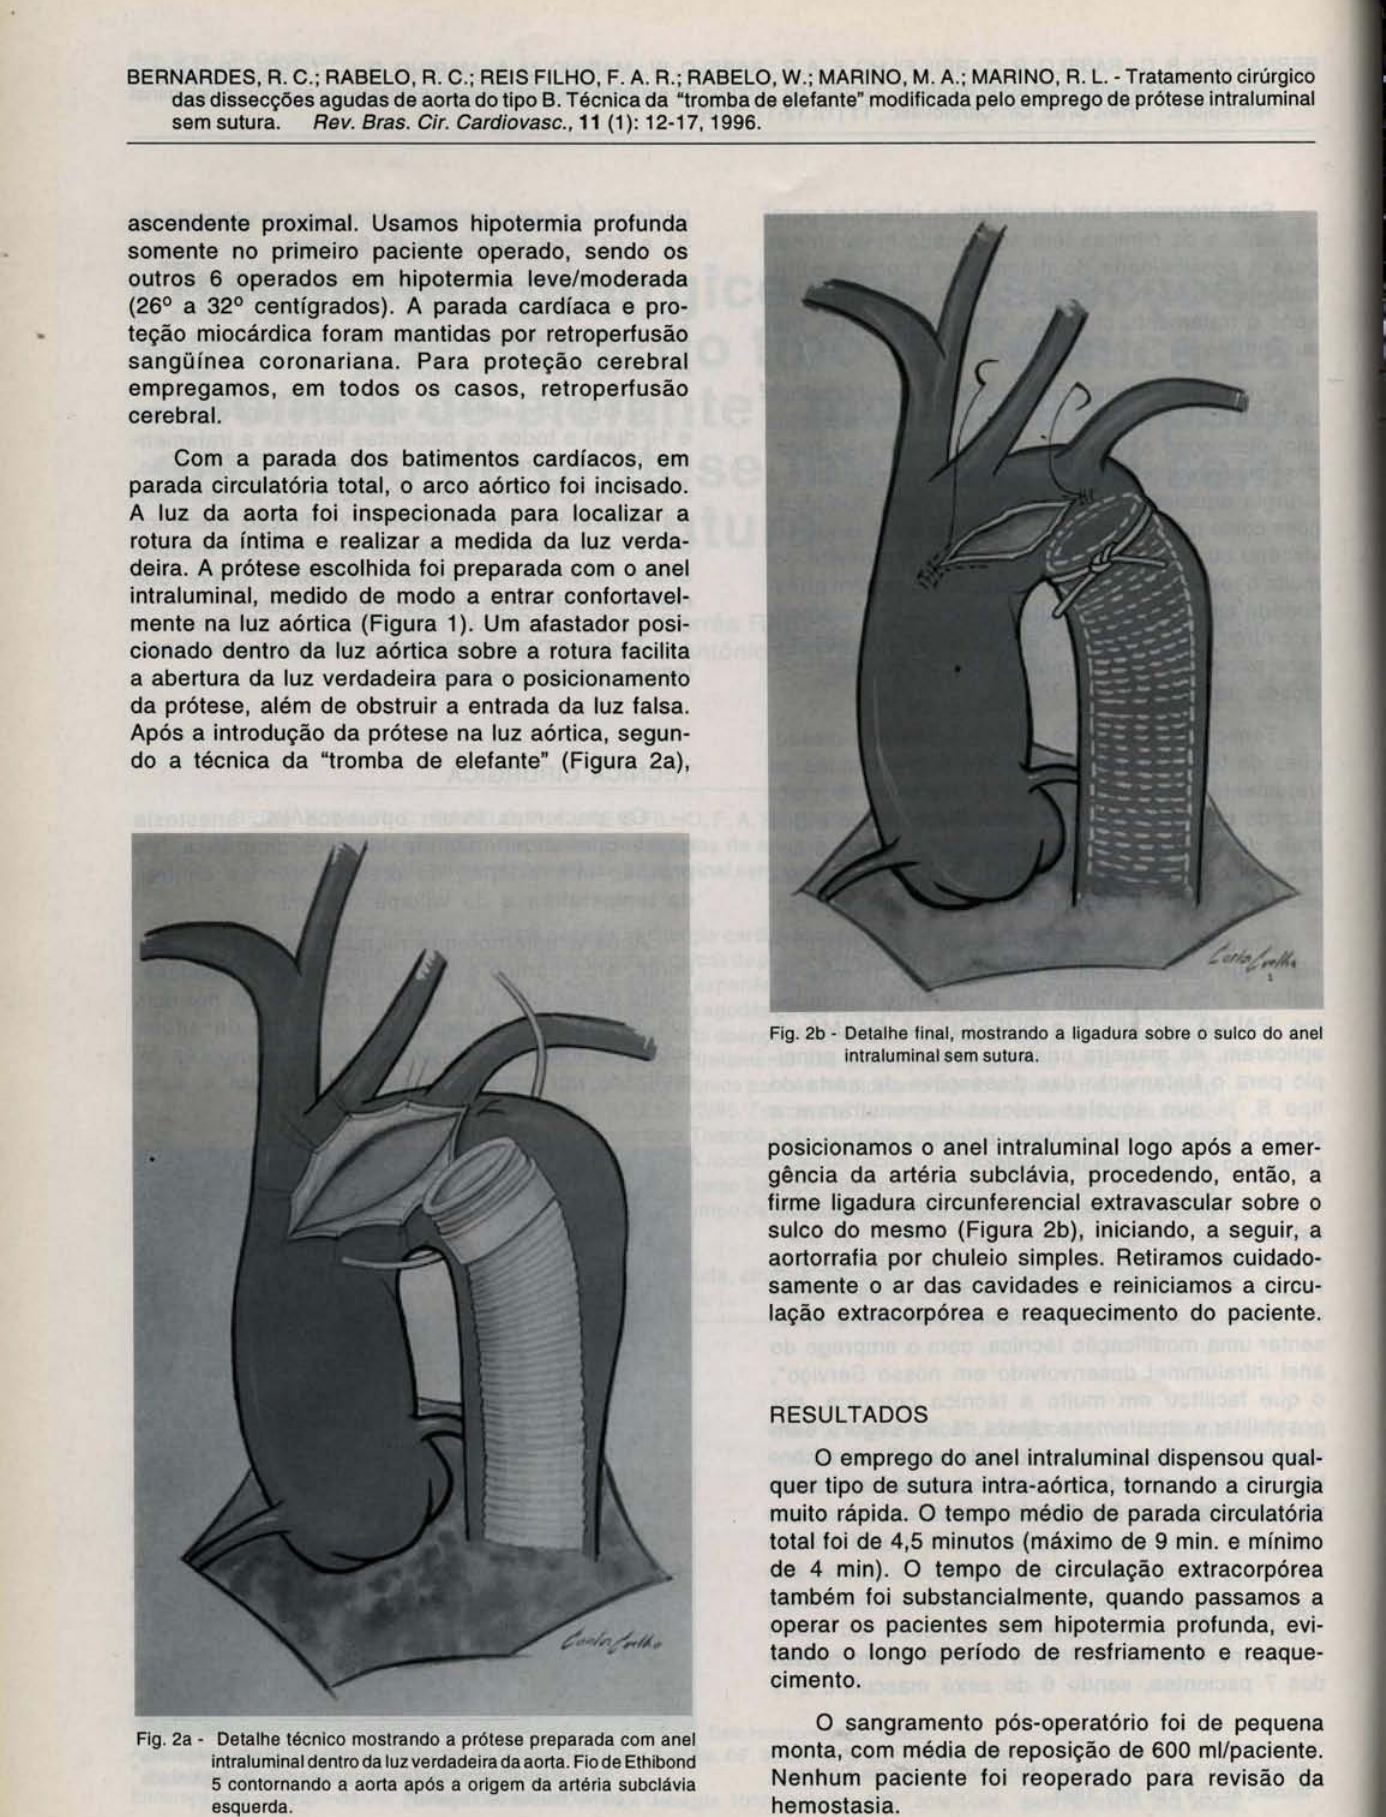
Fig. 2a - Detalhe técnico mostrando a prótese preparada com anel intraluminal dentro da luz verdadeira da aorta. Fio de Ethibond